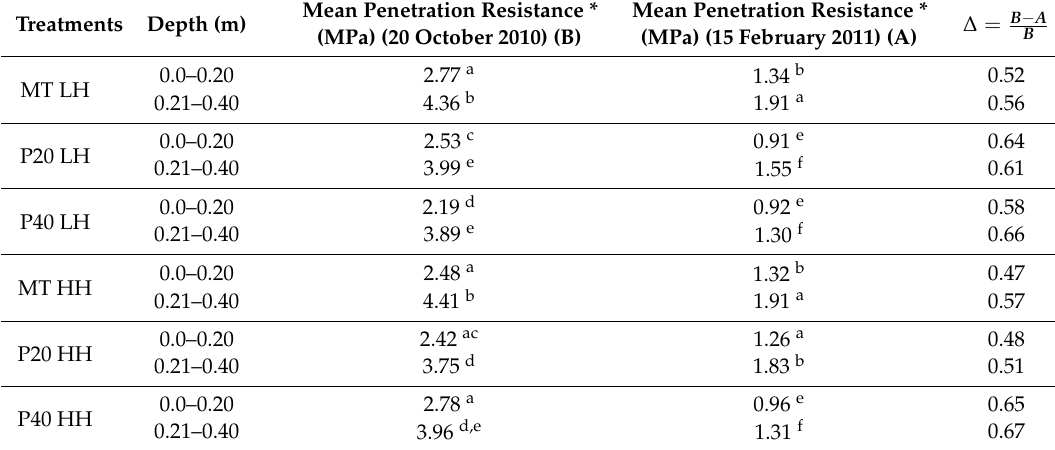
Table 2. Mean values of soil layers from 0 to 0.40 m, depth of penetration resistance carried out before (B) and after (A) tillage and its increment ratio ∆